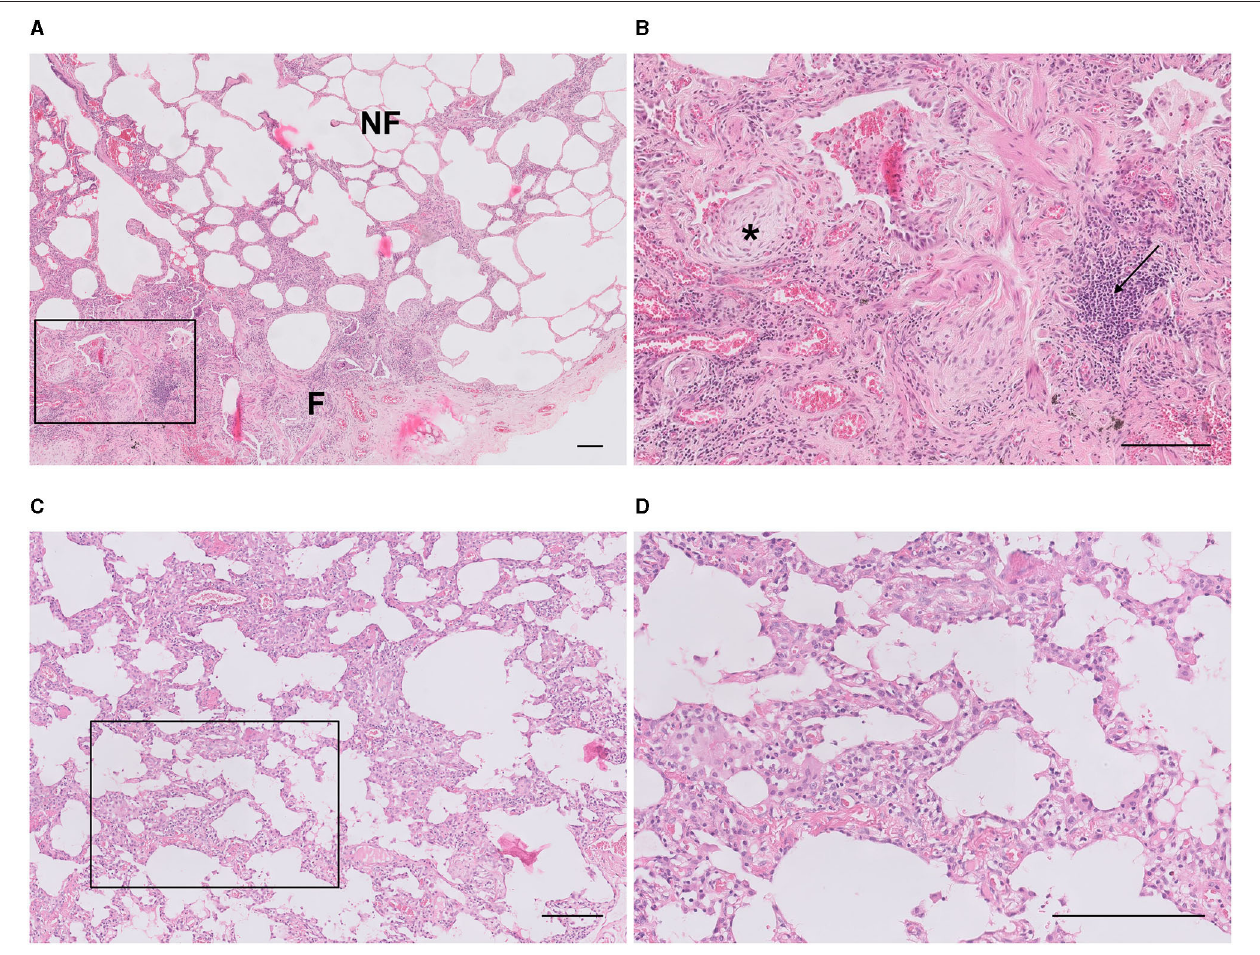
FIGURE 1 | Representative Hematoxylin and Eosin (H&E)-stained diagnostic biopsies of FPF/IPF and cNSIP lungs. Images of typical (A) FPF/IPF and (C) cNSIP lung biopsies. (B,D) Magnifications of boxed areas in images (A,C) , respectively. Fibroblast foci (asterisk) and lymphocyte aggregates (arrow) were digitally quantified in the whole biopsy and the amount of diffuse inflammatory cell infiltrate (blue-purple nuclei) of the whole biopsy was scored using a histological grade from 1 to 4. Horizontal bars represent a size of 200 µ m. FPF, Familial pulmonary fibrosis; IPF, idiopathic pulmonary fibrosis; cNSIP, cellular non-specific interstitial pneumonia; NF, non-fibrotic area; F, fibrotic